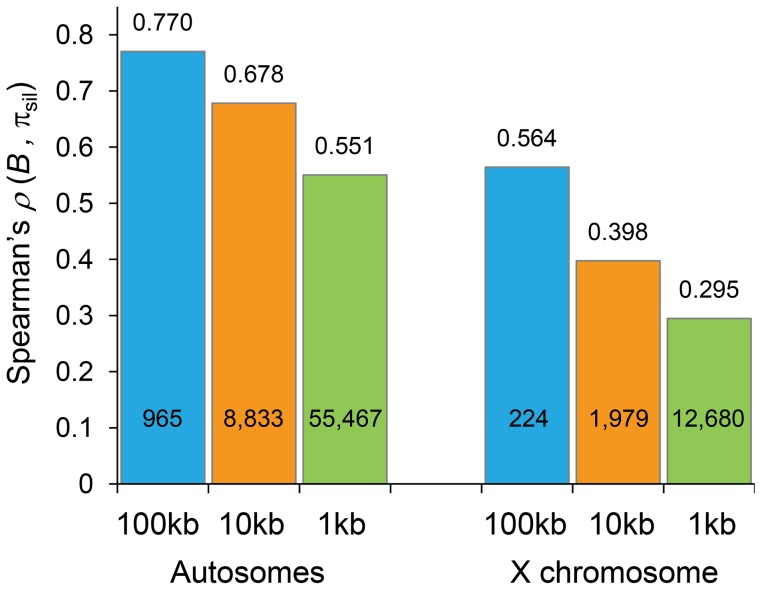
Correlation coefficients between estimates of B and levels of polymorphism at noncoding sites (πsil).Spearman's rank correlation coefficients (ρ) based on the analysis of 100-, 10- and 1-kb non-overlapping regions are shown above columns (P<1×10−12 in all cases) and the number of regions analyzed is shown within columns. Results shown for the default model MLN,StdMut,CO+GC.